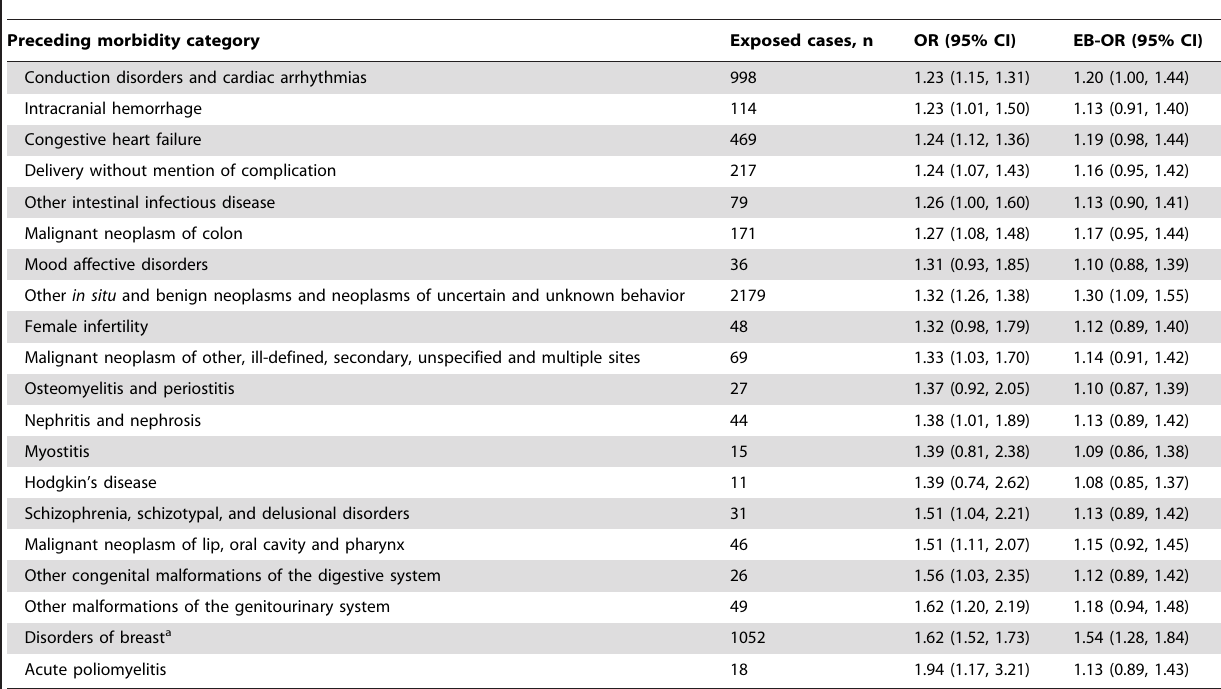
Table 6. The 20 preceding morbidity categories most strongly associated with increased breast cancer